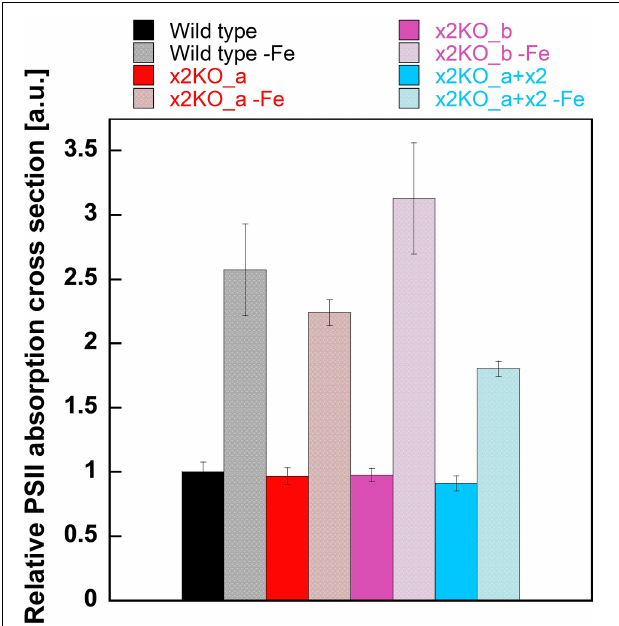
FIGURE 5 | Functional absorption cross section of PSII ( σ PSII) in iron-replete and iron-limited Phaeodactylum tricornutum wild type and mutant strains. To measure σ PSII, dark-acclimated cells were treated with DCMU and exposed to a red-light flash after 5 s (for details, refer to Section “Materials and Methods”). Values are normalized on the relative PSII functional absorption cross section of wild type cells grown in an iron-replete medium. Mean values are derived from three to six independent replicates. SE is